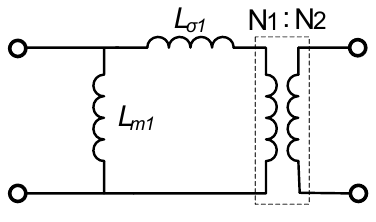
Figure 5. The equivalent L model of the transformer.